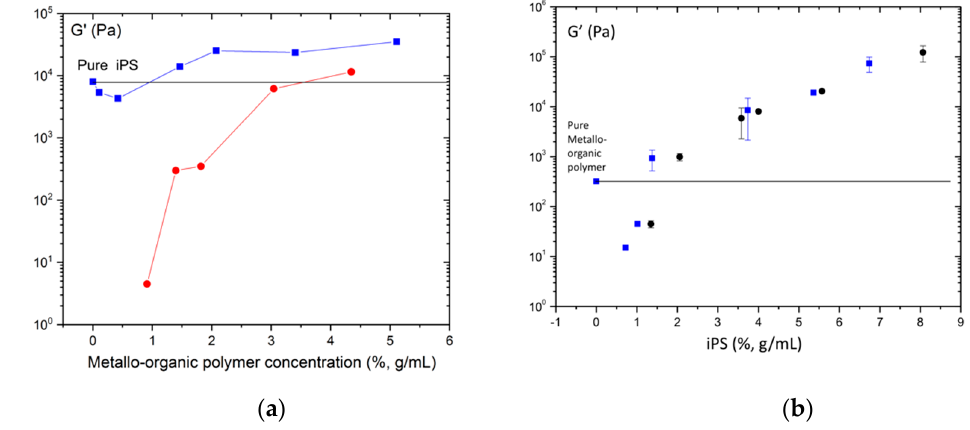
Figure 5. ( a ) Equilibrium storages modulus plateau as a function of metallo-organic polymer concentration for hybrid gels with a fixed iPS concentration of 4%, g/mL (blue square) and for pure metallo-organic polymer gels (red circle); ( b ) equilibrium storages modulus plateau as a function of iPS concentration for hybrid gels with a fixed metallo-organic polymer concentration of 1.4%, g/mL (blue squares) and for pure iPS gels (black circle).